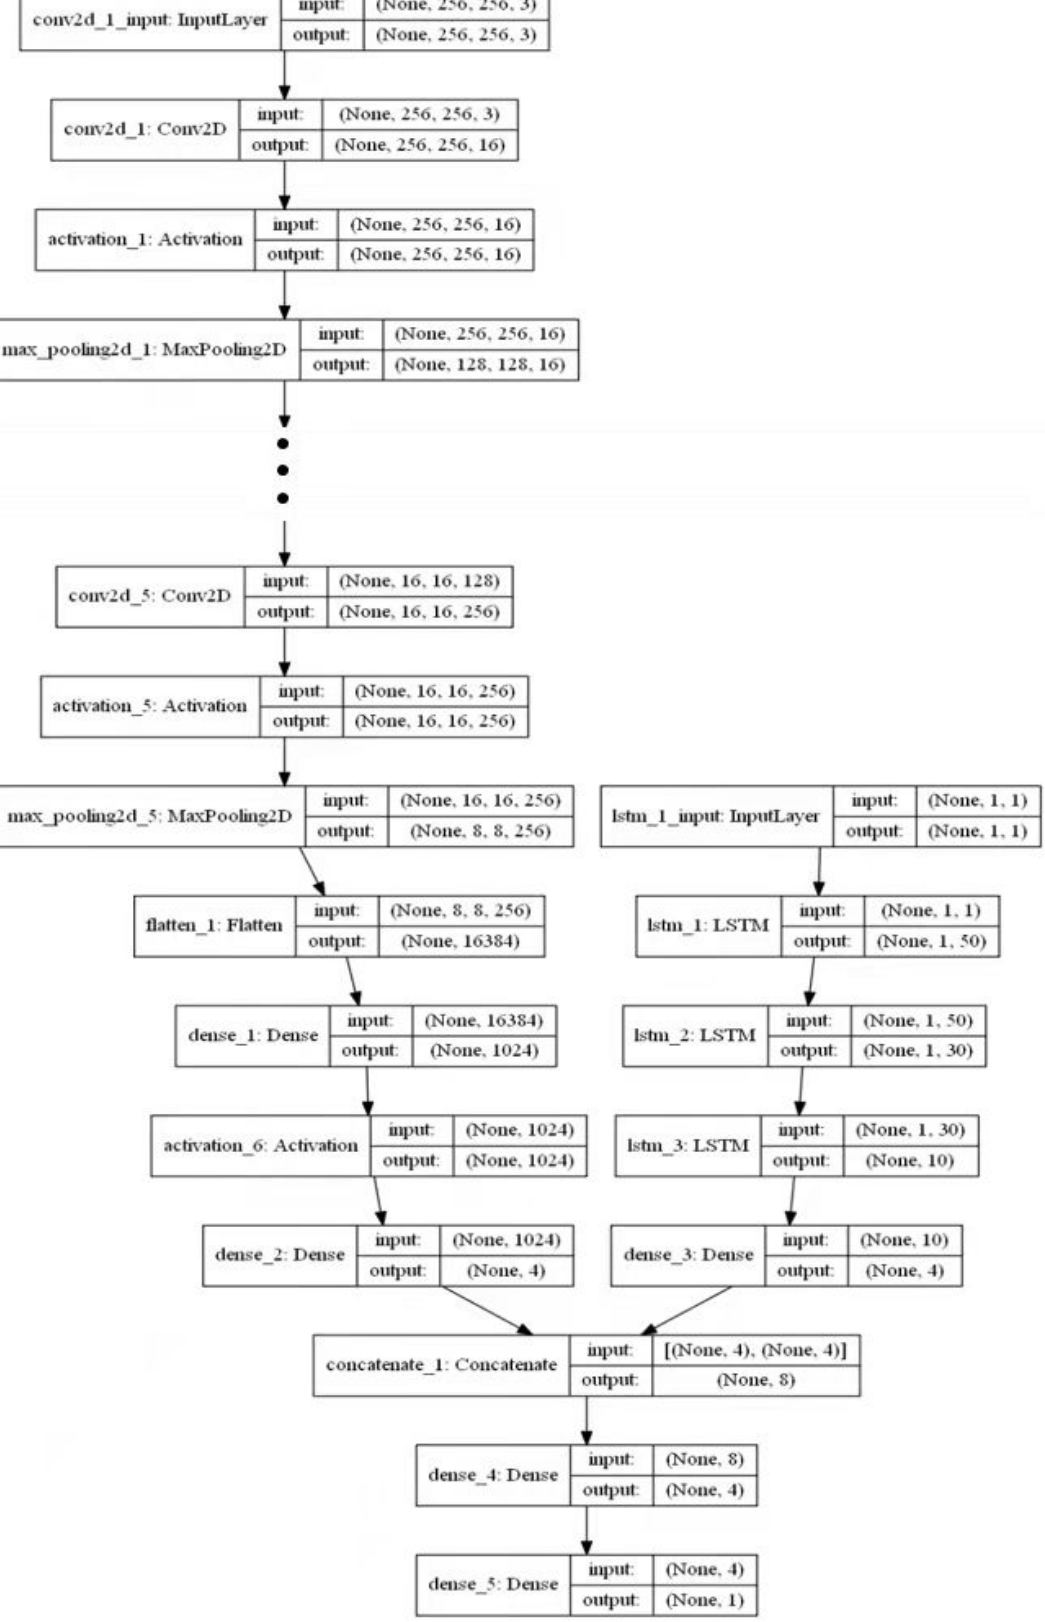
Figure 13. Schematic view of deep convolutional neural network–long-short term memory (DCNN–LSTM) model.